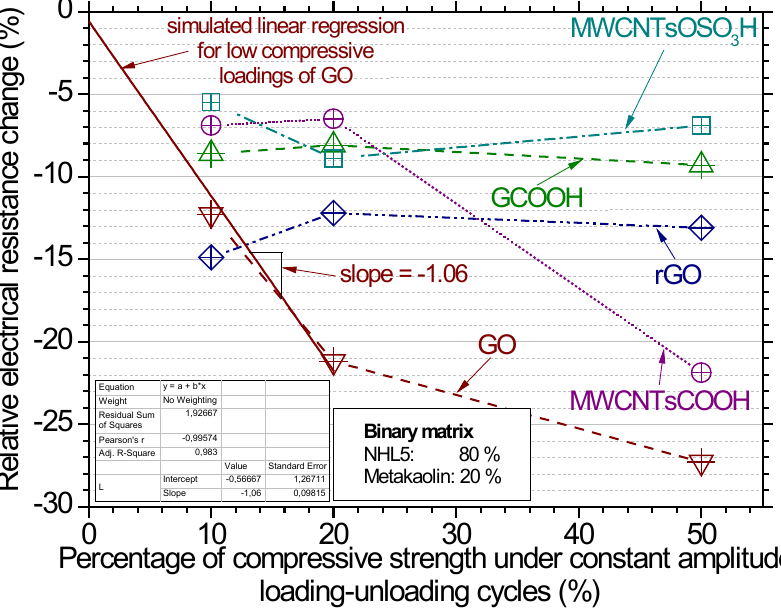
Figure 15. Average relative resistance change (%) for all investigated carbon nanostructures reinforced pastes for the different mechanical loading levels under compression.